Question: Provide a one-line summary of what is displayed.
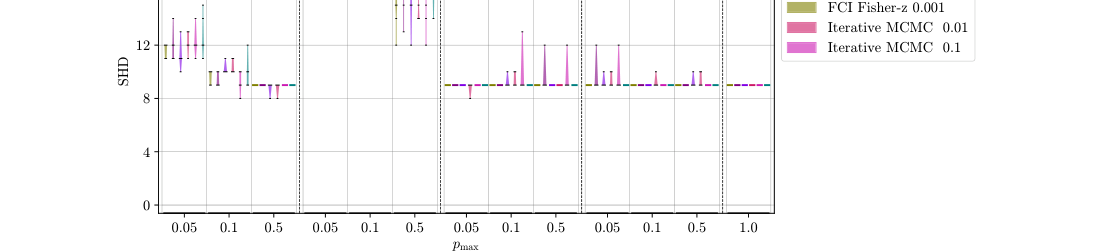
Answer: Sachs data, SHD. The results for PC algorithm with Gaussian CI test and alpha value 0.001; GES algorithm with BIC score and penalty discount values 0.8 and 1.5; FCI algorithm with Fisher-z CI test and alpha values 0.001; Iterative MCMC algorithm with BGe score and alpha values 0.01 and 0.1. The width of each bar varies for different values on the y-axis proportionally to the number of samples attaining that value.